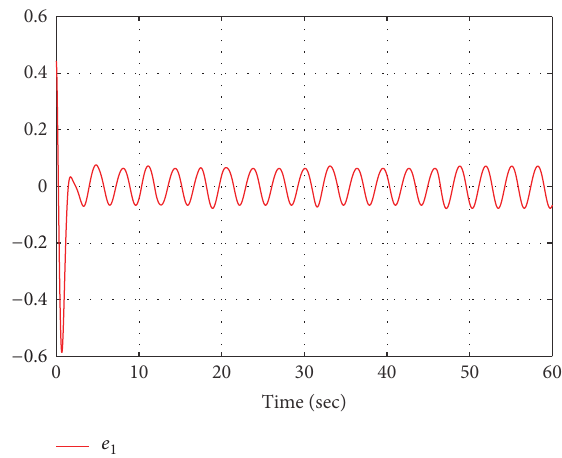
Figure 3: The trajectory of tracking error 𝑒 1